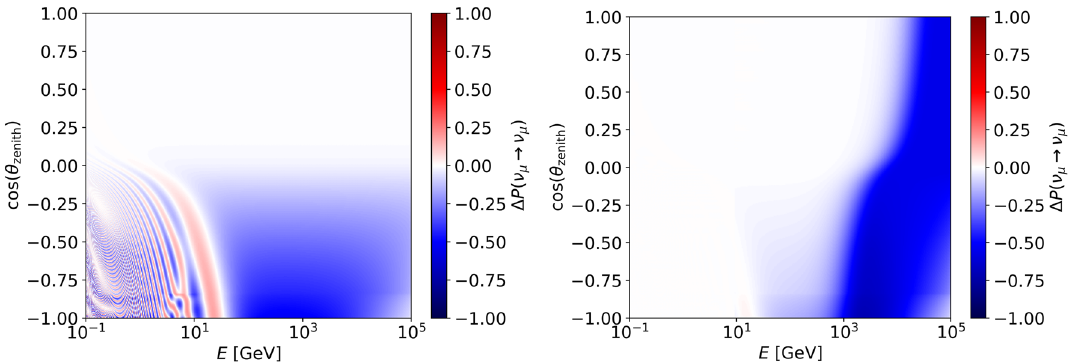
distance. Here, the coherent length is set ∼ 2 R ⊕ and the natural scale is chosen to be 1 TeV, corresponding to γ 0 sensitivity of 1 . 3 × 10 − 23 GeV ( n = 0) and 1 . 3 × 10 − 29 GeV ( n = 2). Figures are taken from [456]